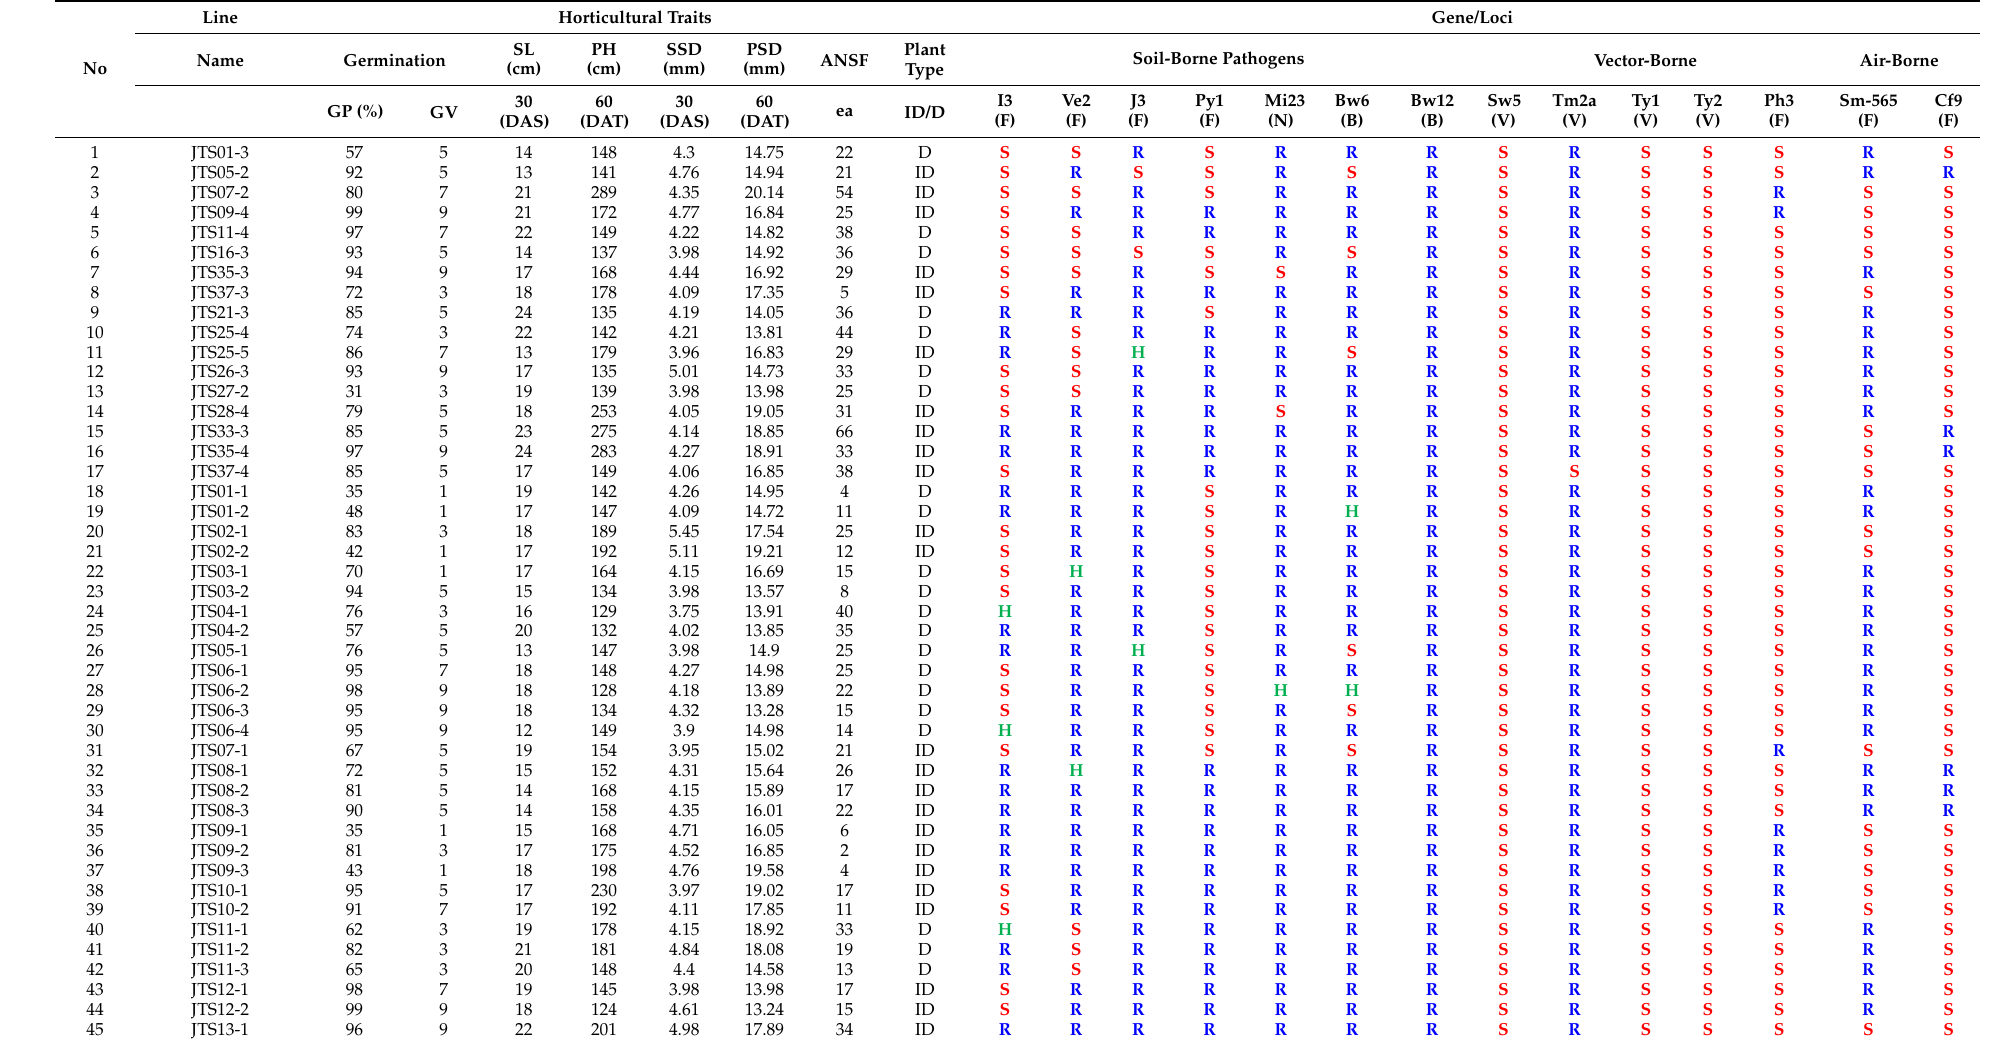
Table 1. List of horticultural traits and gene/loci of Solanum lycopersicum